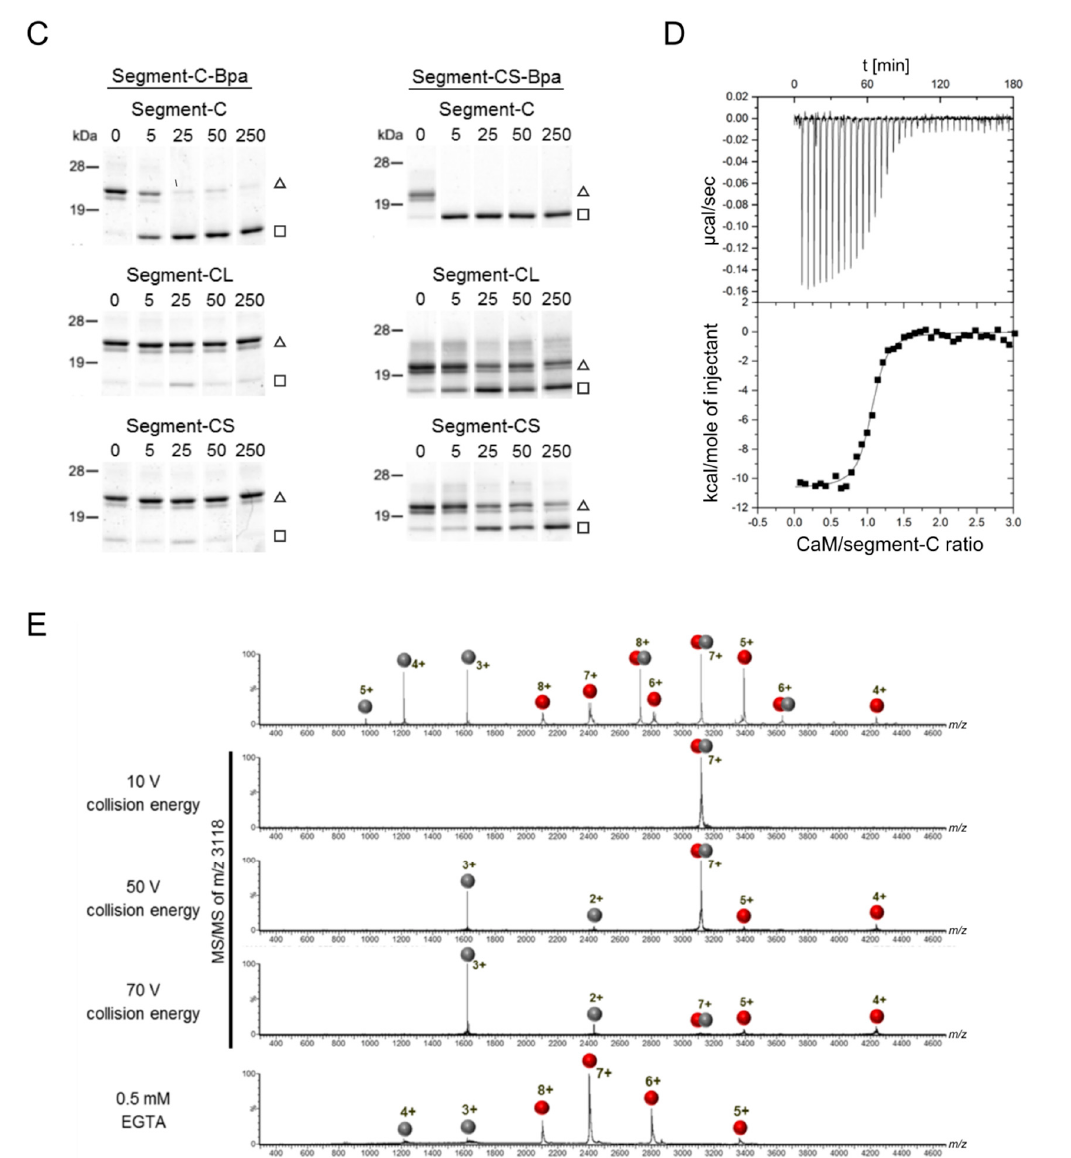
Figure 5. Complex formation between CaM and the segment-C. ( A ) Ca 2 + concentration required for complex formation. The Coomassie stained gradient (4–20%) SDS-PAGE gel illustrates cross-linking of the CaM / segment-C complex at increasing Ca 2 + concentrations. Bu ff er and cross-linking conditions were identical to Figure 2. The complex was covalently connected by photo-cross-linking via the incorporated photo-Met in CaM. (M) Prestained Protein Ladder, ( (cid:3) ) CaM, ( ) segment-C and ( ∆ ) (cid:35) CaM / segment-C 1:1 complex. ( B ) Identified cross-links between CaM and segment-C. All cross-links are illustrated as a Circos plot within the whole segment-A for comparison with previous results. CaM is colored in red, segment-A in gray and the binding sites in light and dark green within the segment-A. ( C ) PAL-based competition assay of segment-C-Bpa and segment-CS-Bpa with segment-C, -CS and -CL. ( (cid:3) ) CaM, ( ∆ ) CaM / segment-C-Bpa or CaM / segment-CS-Bpa 1:1 complex. Complete SDS gels and corresponding mass spectra are shown in Figure S10. ( D ) A ffi nity measurements. ITC experiments were performed at 6.14 µ M Ca 2 + , applying CaM in the reaction cell and segment-C in the syringe. A binding event was detected for N = 1.04, K D = 43 ± 8 nM, ∆ H = 10.68 ± 0.17 kcal · mol − 1 and ∆ S = − 2.12 cal · mol − 1 · K − 1 . ( E ) Native ESI-MS. The ITC sample (CaM and segment-C) was subjected to bu ff er exchange prior to mass spectrometric analysis. The sample was analyzed in the absence (upper panel) and presence of EGTA (lower panel). MS / MS experiments were performed for the 7 + charged precursor ion of the complex at m / z 3118. CaM is depicted as red spheres and segment-C as gray